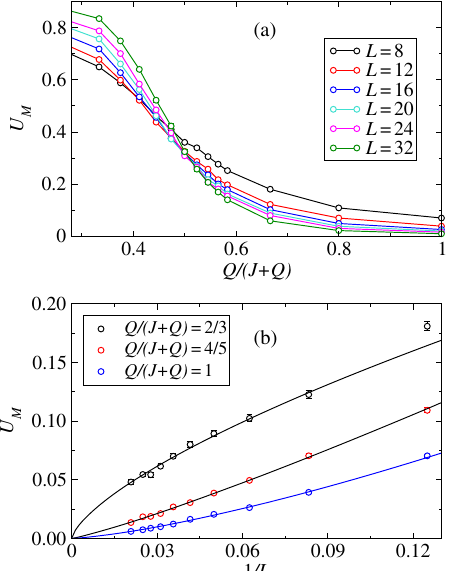
FIG. 9. AFM Binder cumulant of the random- Q model. In (a), the results for several different system sizes are graphed versus the coupling ratio Q= ð J þ Q Þ , and in (b), the results for three different cases inside the RS phase are graphed vs the inverse system size along with power-law